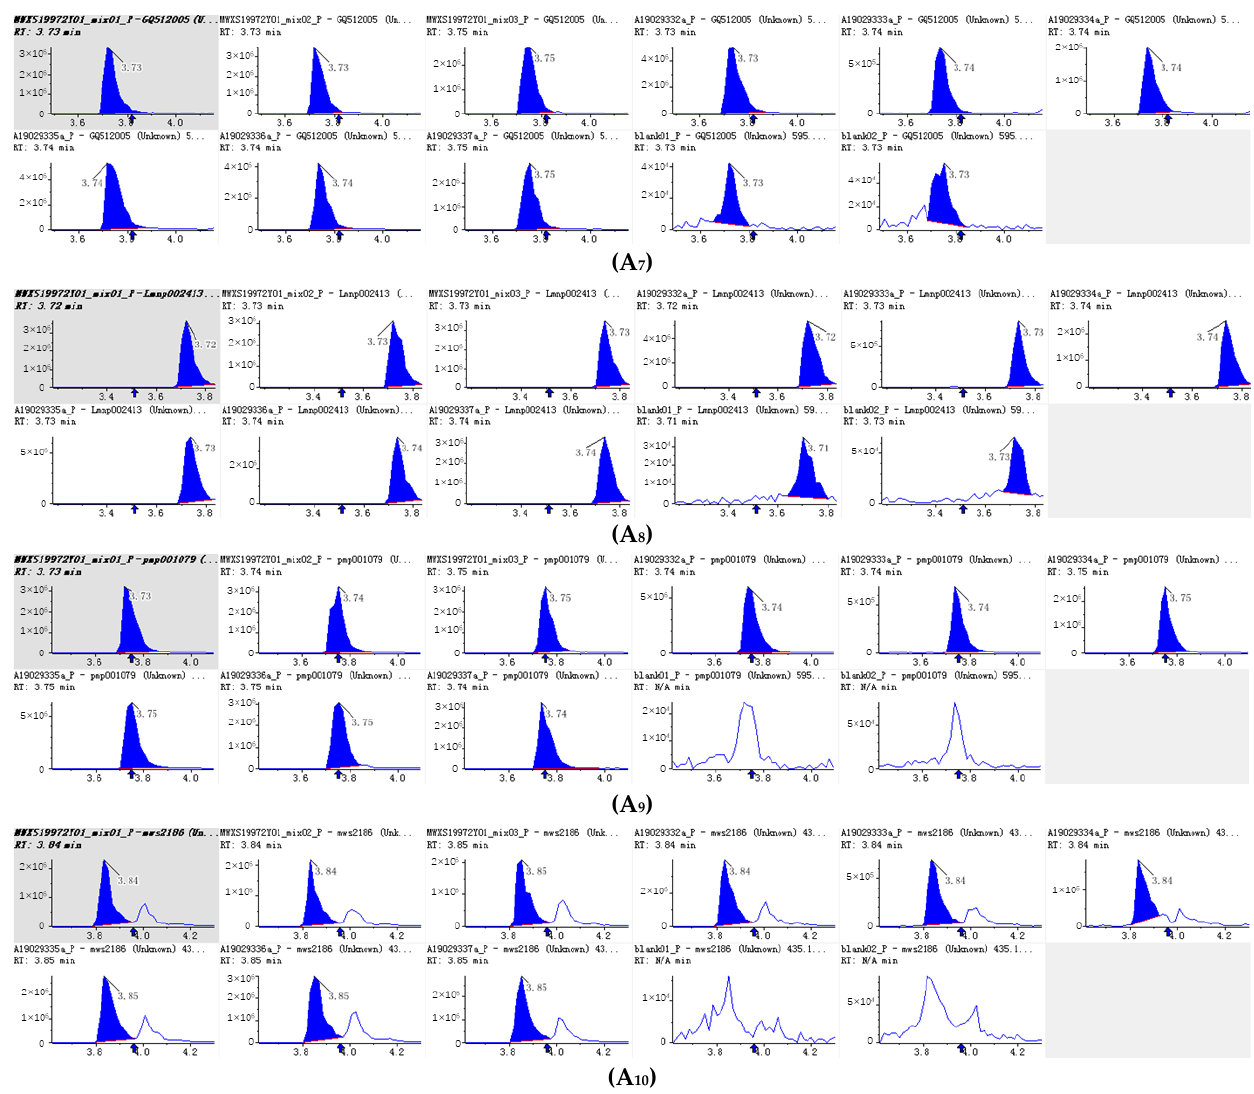
Figure 4. Integral diagram of Luteolin 7-O-glucoside (Cynaroside) ( A 1 ), Kaempferol 3-O-rutinoside (Nicotiflorin ( A 2 ), Quercetin-3- O - α -L-rhamnopyranoside ( A 3 ), Kaempferol-3- O -neohesperidoside ( A 4 ), Luteolin-7- O -rutinoside ( A 5 ), Kaempferol 3- O -robinobioside (Biorobin ( A 6 ), Kaempferol-3- O -glucoside-7- O -rhamnoside ( A 7 ), Tetrahydroxyflavone-C-rhamnosyl-glucoside ( A 8 ), Lonicerin ( A 9 ) and Avicularin ( A 10 ) quantitative analysis in PFDF.quantitative analysis in PFDF. The abscissa is the retention time of metabolites (min), the ordinate is the ion current intensity of metabolites (cps), and the peak area represents the relative content of substances in the sample. The arrow in the figure indicates that the position of retention time corresponds to the RT value in the